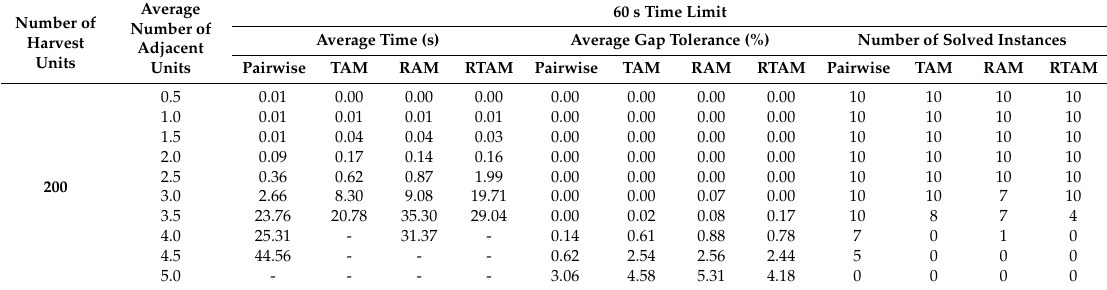
Table 2. Solving time, gap tolerance and number of solved instances for 60 s time limit and 200 harvest units.